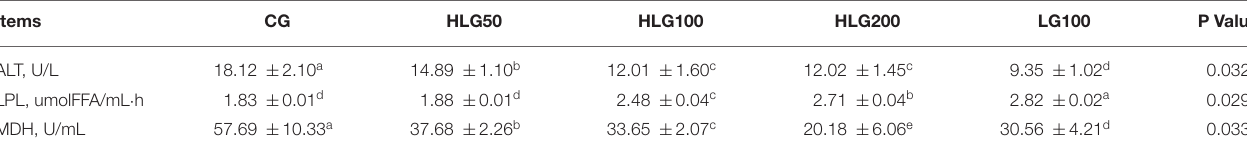
TABLE 6 | Effects of hydroxylated lecithin on enzymes activity related to lipid metabolism in serum of Jiangnan White goslings.